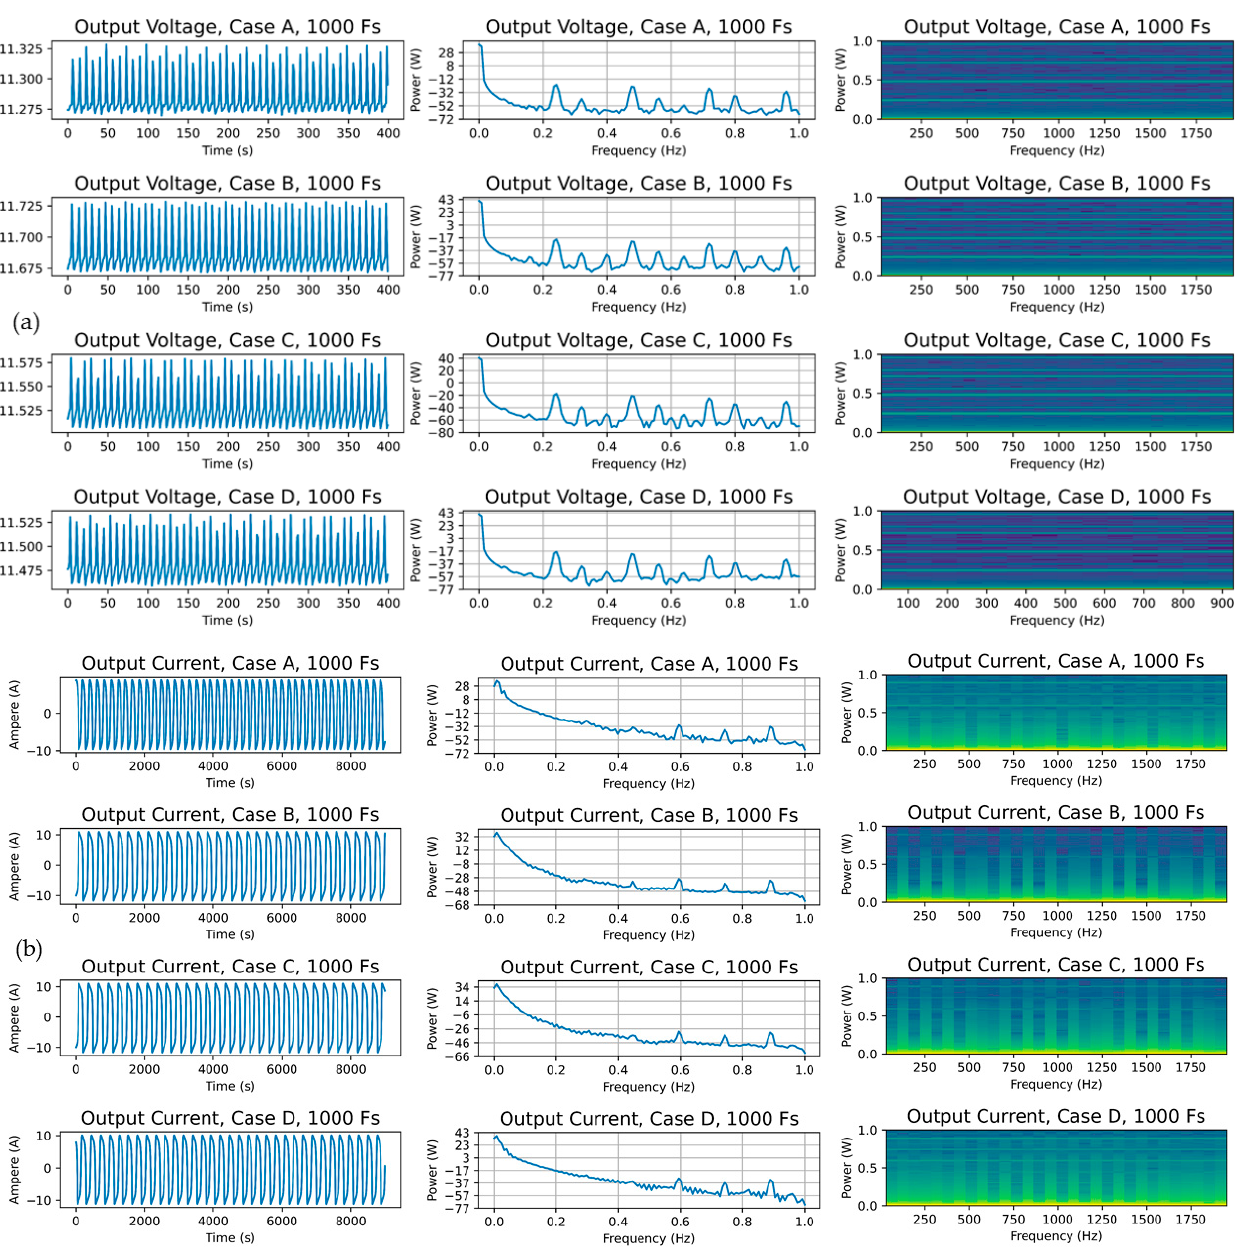
Figure 6. Raw Output Signal, PSD, and Spectrogram of the SMPS for different faults. ( a ) Output Voltage Signal. ( b ) Output Current Signal.